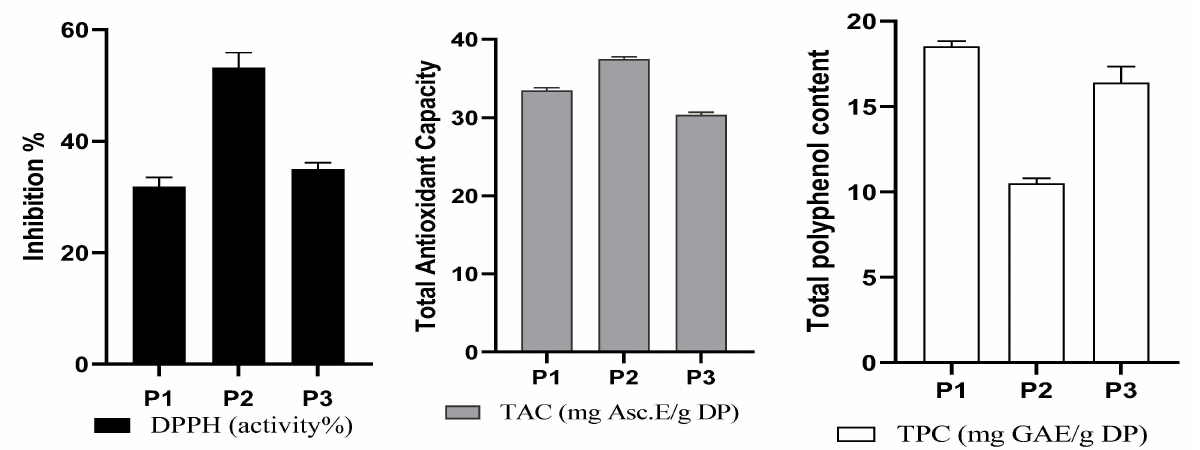
Figure 1. Antioxidant activities (DPPH and TAC) and total polyphenol content (TPC) of the screened plants. Values are means ± SD (n = 3). P1: parsley, P2: coriander, P3: